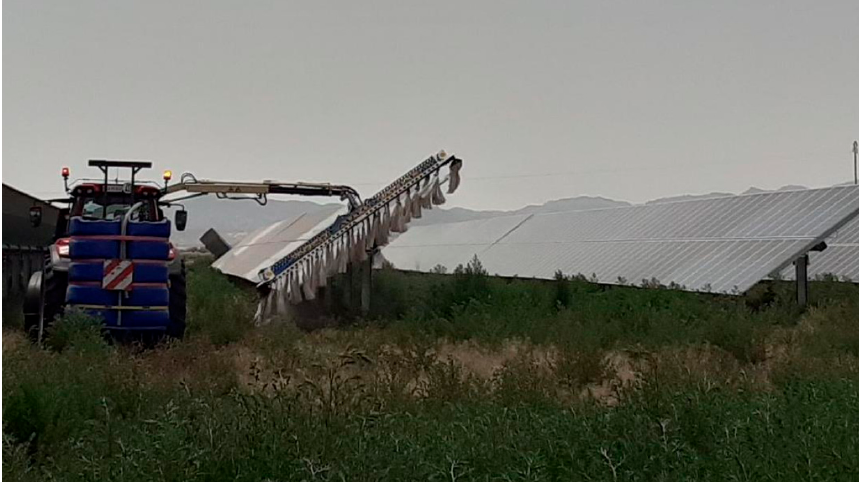
Figure 2. Tractor-operated traditional cleaning method in a large PV power plant.